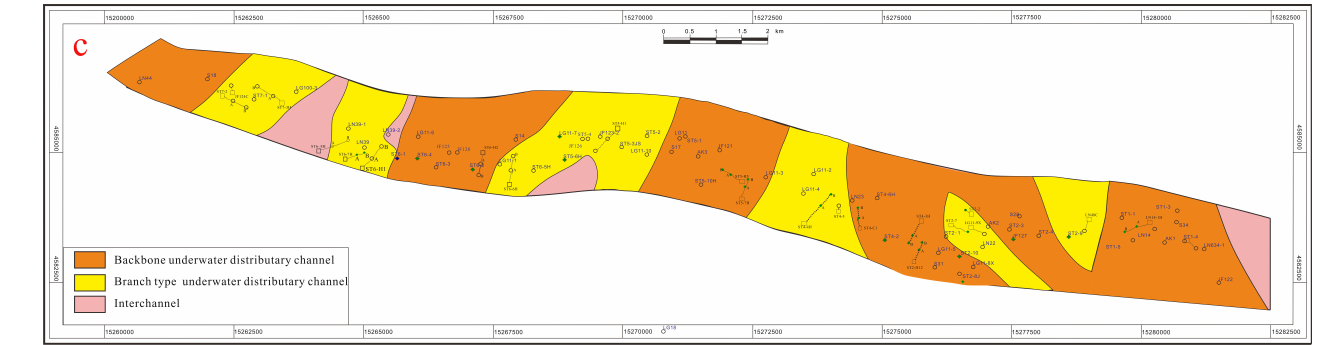
Figure 9. Architecture plan of TIII1 in the Sangtamu Oilfield. ( a ) TIII1-1; ( b ) TIII1-2; ( c ) TIII1-3.